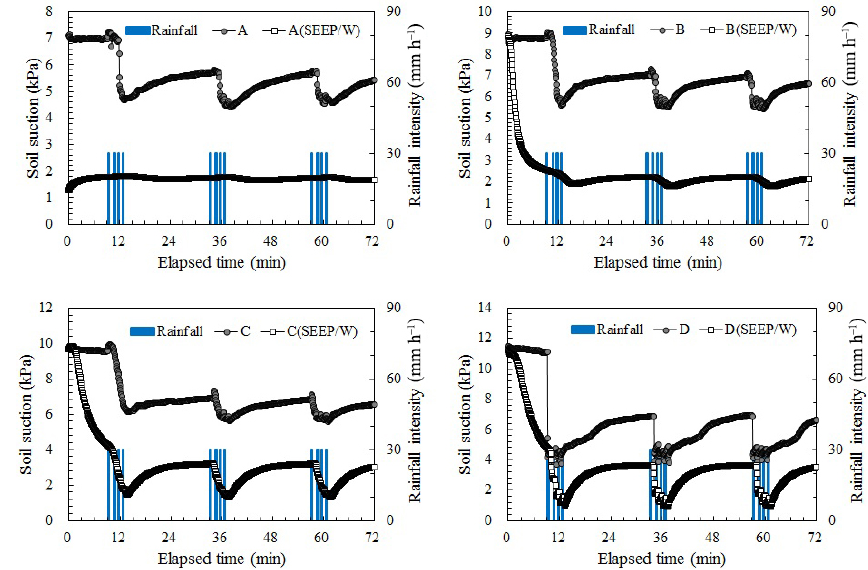
Figure 7. Comparison of soil suction of experimental data and results of numerical analysis in the model slope of 50 ◦